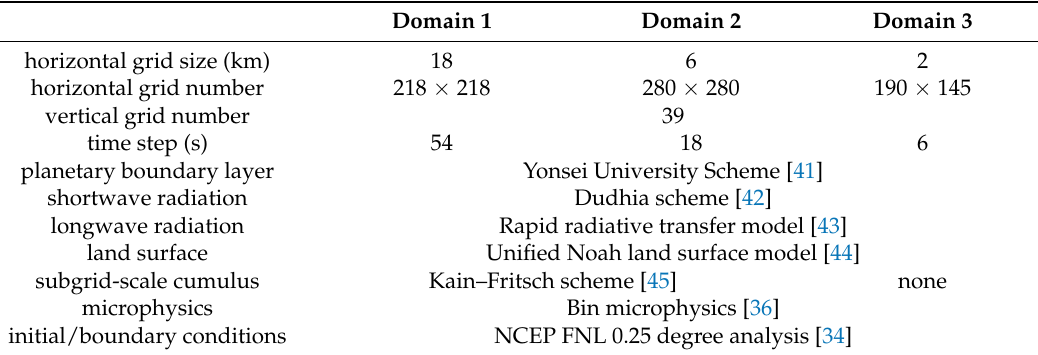
Table 1. Domain configuration and physics schemes used in this